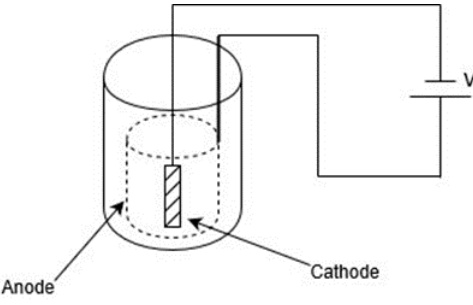
Figure 1. Electrochemical cell for hydrogen charging.